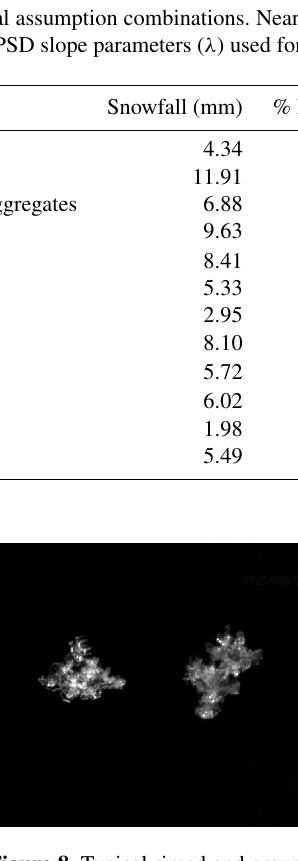
Table 3. Retrieved snowfall amounts for a 15 May snow event for retrieval assumption combinations. Nearby NWS observations suggested